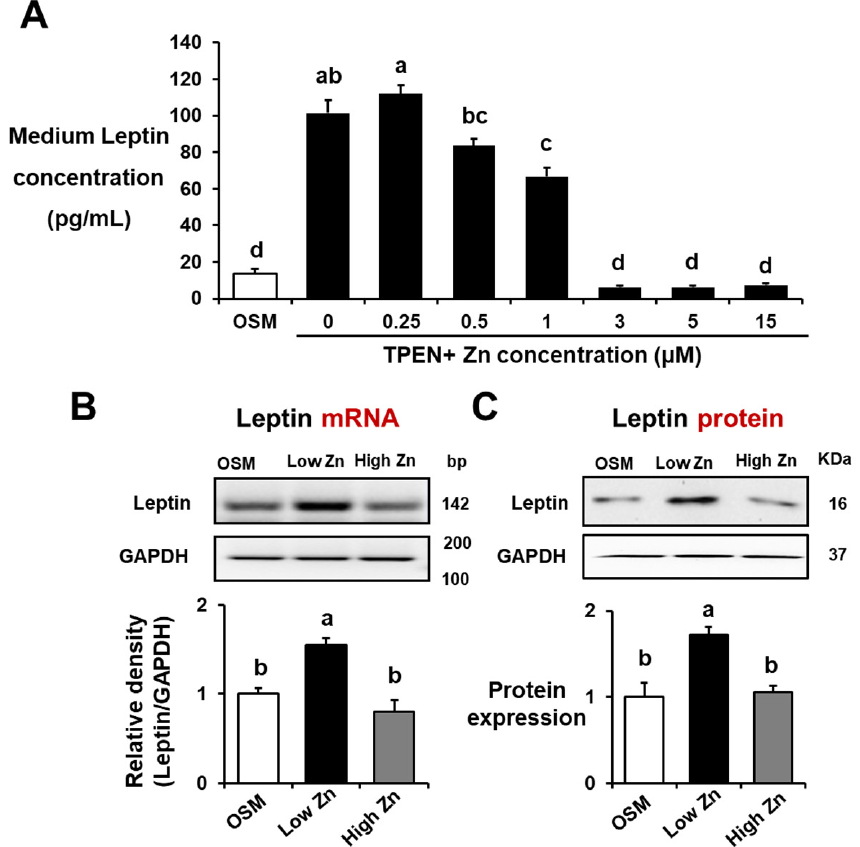
and high Zn concentrations (3–15 µ M) in MC3T3-E1 cells (Figure 2A). Using RT-qPCR and western blotting, we assessed leptin mRNA and protein expression in MC3T3-E1 cells as a result of Zn deficiency. As demonstrated earlier in Figure 2A, the leptin mRNA and protein expression in MC3T3-E1 cells was also significantly increased in low Zn (Figure 2B,C). These results suggest that the leptin secretion, mRNA and protein expression were regulated by Zn levels, indicating the importance of Zn modulation of leptin signaling in osteoblasts.